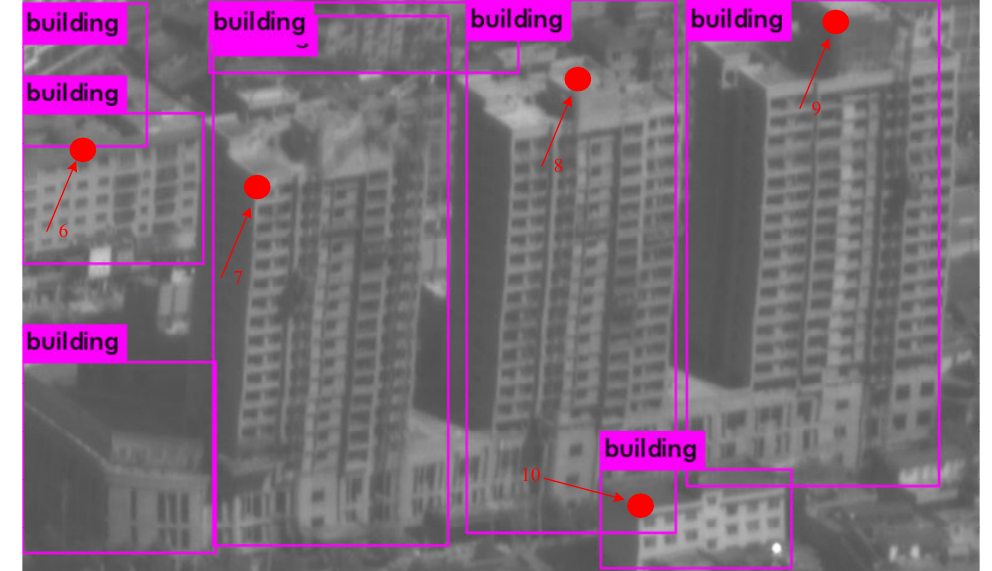
Figure 16. Schematic diagram of building detection results 2. Table 3. Positioning results of Figure 15.